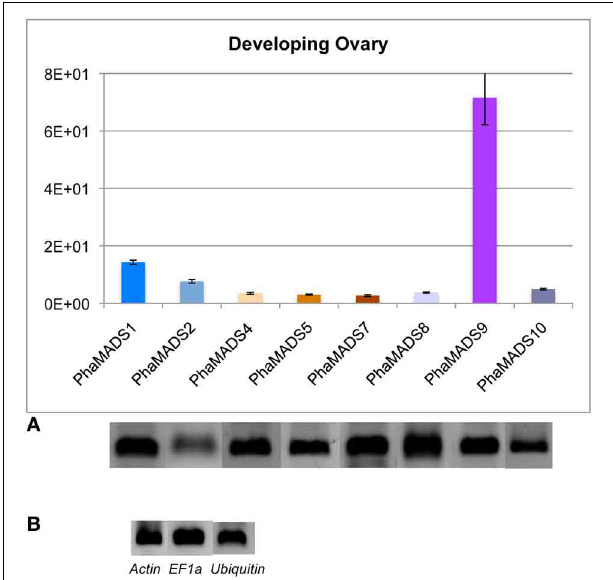
FIGURE 8 | Normalized expression of orchid FUL -, SEP -, AG -, and STK -like MADS-box genes in developing ovary. (A) Normalized expression of MADS-box genes PhaMADS1 , PhaMADS2 ( FUL -like), PhaMADS4 , PhaMADS5 , PhaMADS7 ( SEP -like), PhaMADS8 , PhaMADS10 (AG-like) and PhaMADS9 ( STK -like) in developing ovary of Phalaenopsis hybrid “Athens.” (B) Expression of three internal control genes ( Actin , EF1 α and Ubiquitin ) in the developing ovaries. Replicates, normalization, graphics and abbreviations are as described in Figure 5